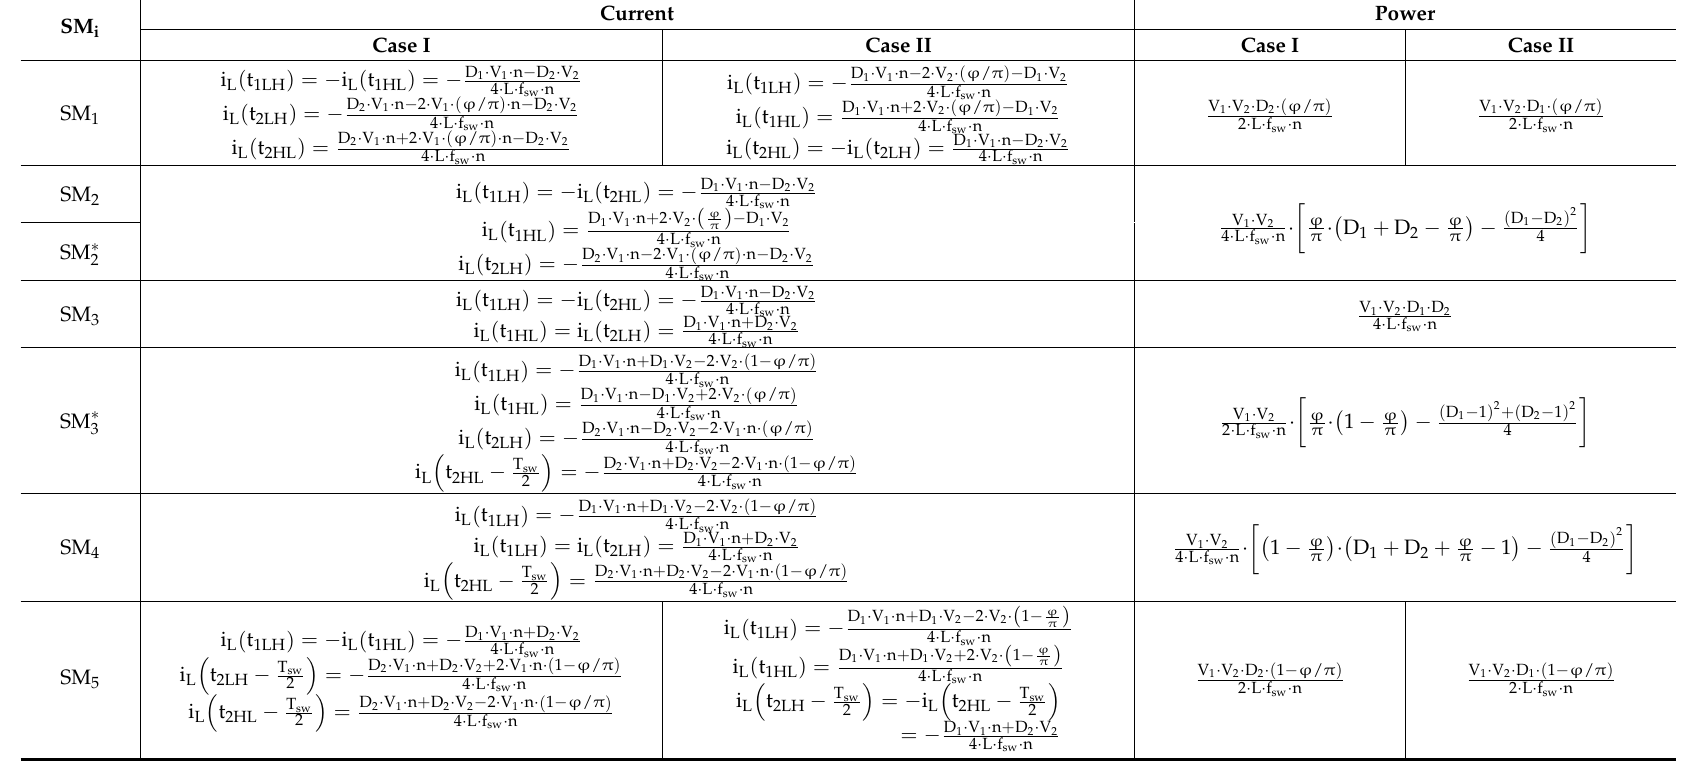
Table 2. Inductor current and output power for Case I and Case